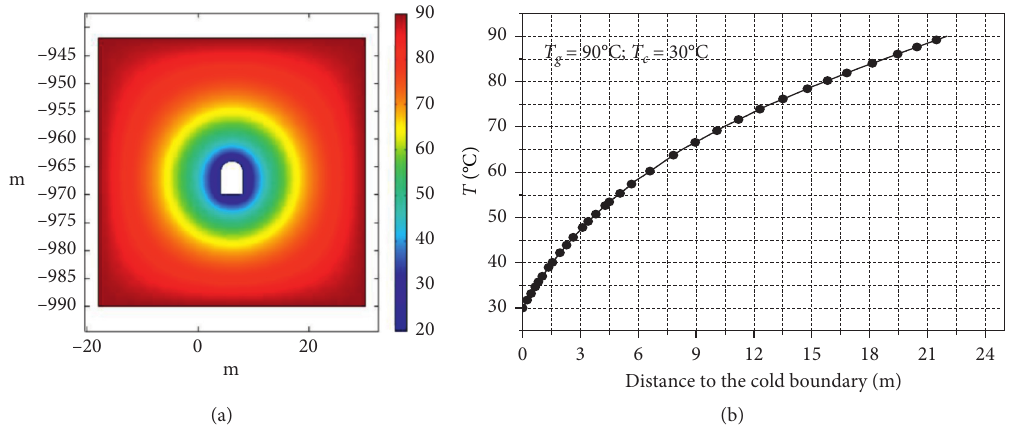
Figure 6: Cloud chart of the thermal field distribution of the surrounding rock (a) and corresponding temperature change curve